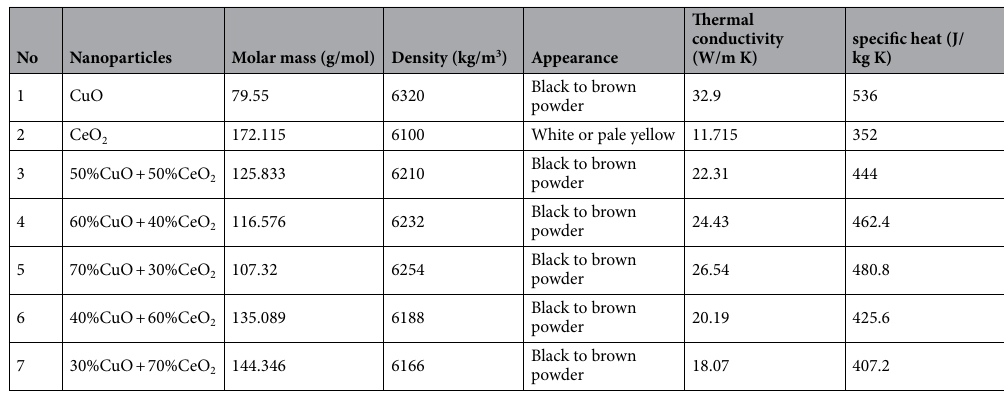
Table 6. Physical and chemical properties of nanoparticles 43